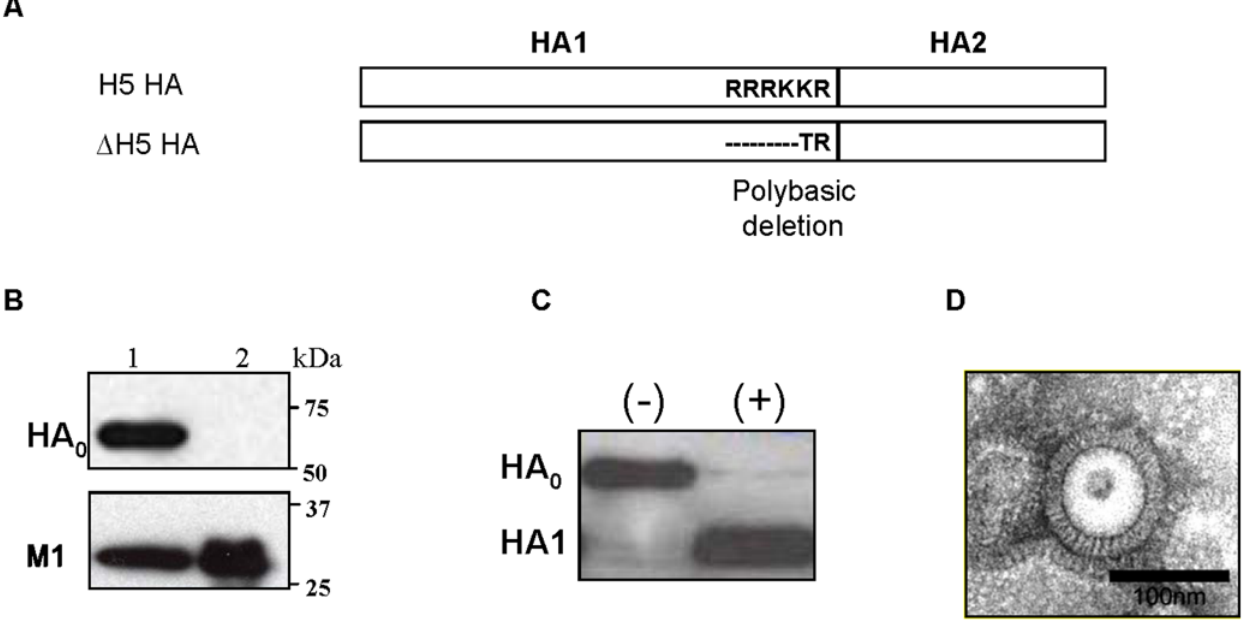
Figure 1. Characterization of influenza H5N1 VLPs. A) A schematic diagram of wild type and mutant H5 HA. The mutant H5 HA is showing a deletion of polybasic amino acids (RRRKK) in the cleavage region of HA ( D H5 HA). B) Western blot analysis of purified H5N1 VLPs. Lane 1, Influenza H5N1 VLPs. Lane 2, M1 VLPs lacking H5 HA. C) Cleavage of HA in VLPs. H5N1 VLPs were incubated without ( 2 ) or with ( + ) TPCK-treated trypsin (2.0 m g/ml trypsin), resolved on SDS-PAGE, and probed by western blot. D) Negative stain electron microscopy of influenza H5N1 VLPs.